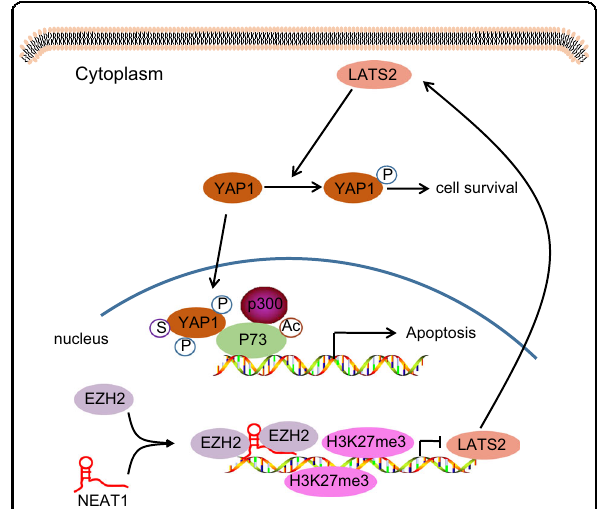
Fig. 7 Proposed underlying mechanism of action of lncRNA NEAT1 in the apoptosis and proliferation of hepatocytes in FHF. In FHF hepatocytes, lncRNA NEAT1 recruits EZH2 to the promoter region of LATS2 and induces the production of H3K27me3, thus repressing the expression of LATS2. Upon inhibition of the LATS2 expression, YAP1 could not be activated and enter the nucleus, which results in binding to P73 and induces the apoptosis mediated by